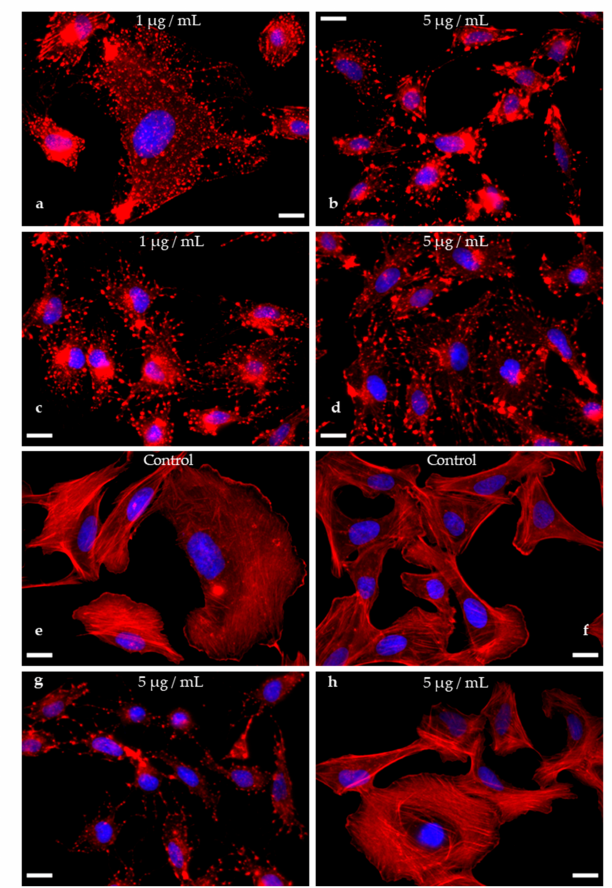
Figure 7. Overlay images of U2OS cells treated with compounds 4 (( a ): 1 µ g/mL; ( b ): 5 µ g/mL; ( g ): 5 µ g/mL, wash-out), 7 (( c ): 1 µ g/mL; ( d ): 5 µ g/mL; ( h ): 5 µ g/mL, wash-out) or vehicle control (DMSO, ( e ): 5 µ l/mL; ( f ): wash-out control), PFA-fixed and stained for their actin cytoskeleton (phalloidin-ATTO594, red) and nuclei (DAPI, blue). Knot-like structures and aggregates of f-actin in treated cells demonstrate the disruptive effect of compounds 4 and 7 in comparison to the intact actin cytoskeleton depicted in the vehicle control ( e ). Note that the effect of 4 is not reversible, as a wash-out ( f ) with a recovery time of one hour did not lead to a regeneration of the f-actin network (compare ( b , g )), while the effect conveyed by compound 7 was fully revertible (compare ( d ) and ( h )). Scales bars set as 20 µ